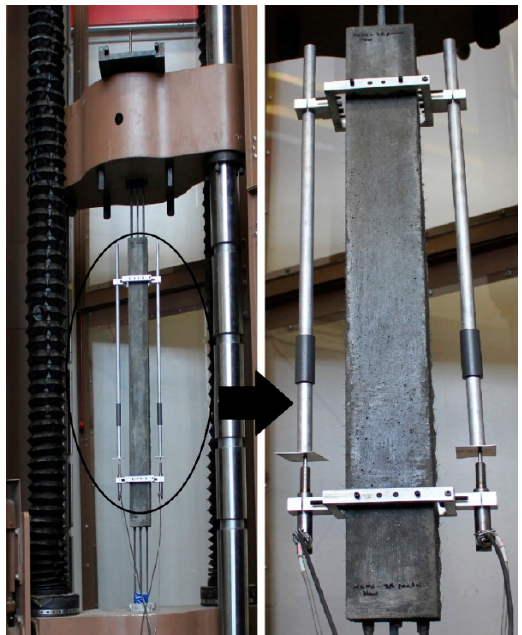
Figure 12. Test set-up with load frame and LVDT holder.